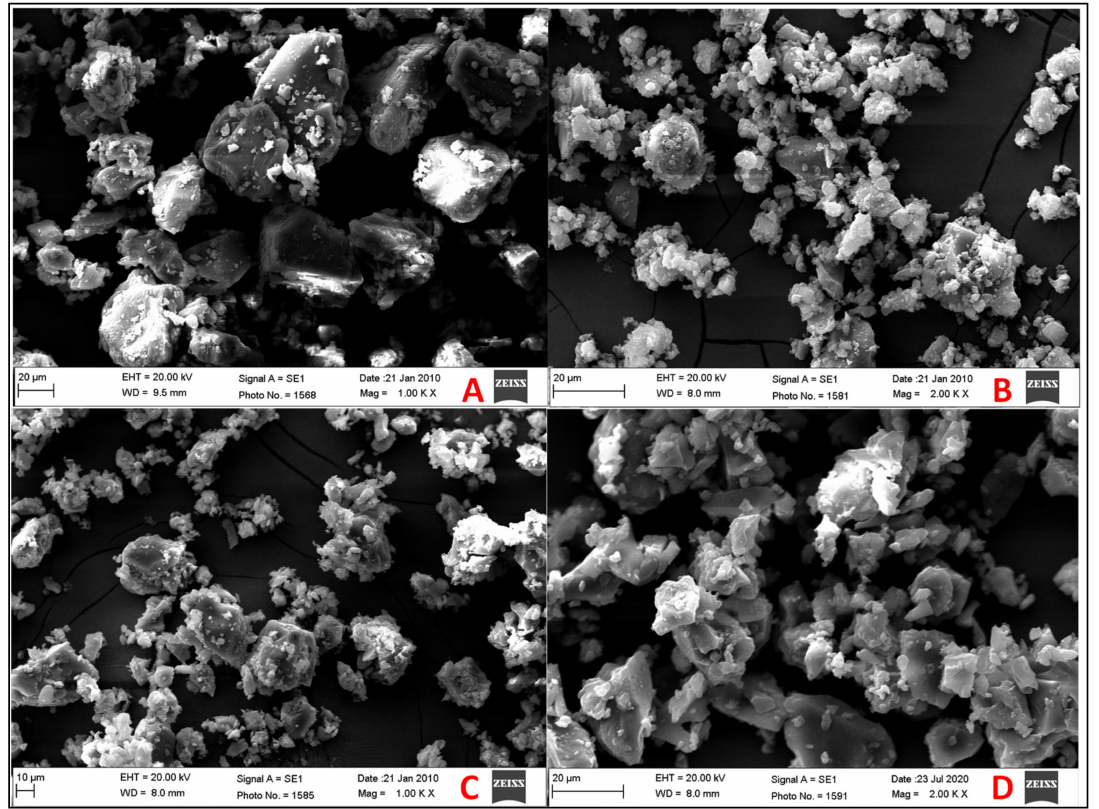
Figure 6. SEM of ( A ) pure piperine, ( B ) PIP ternary physical mixture (PIP TPM), ( C ) PIP ternary inclusion complex ((PIP TIC (MI)), ( D ) PIP ternary inclusion complex ((PIP TIC